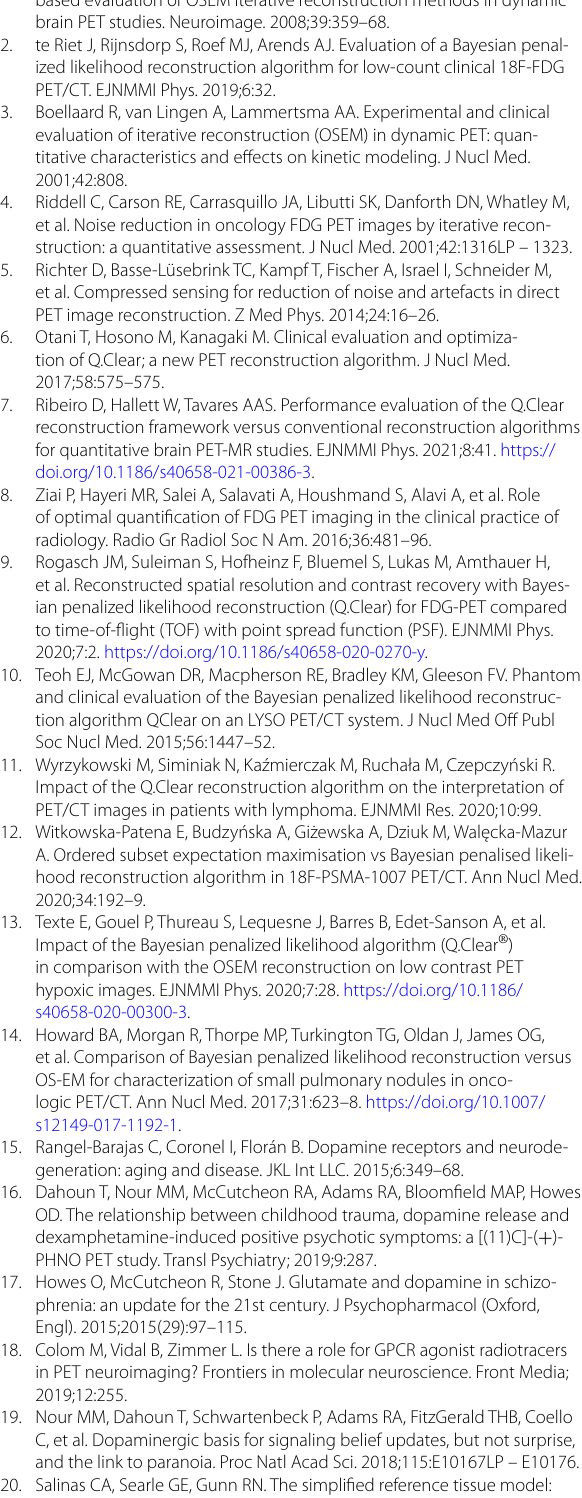
Additional file 7. Table S2. Coefficient of variation obtained for the Sub- stantia Nigra, Striatum, Globus Pallidus, Thalamus, Caudate and